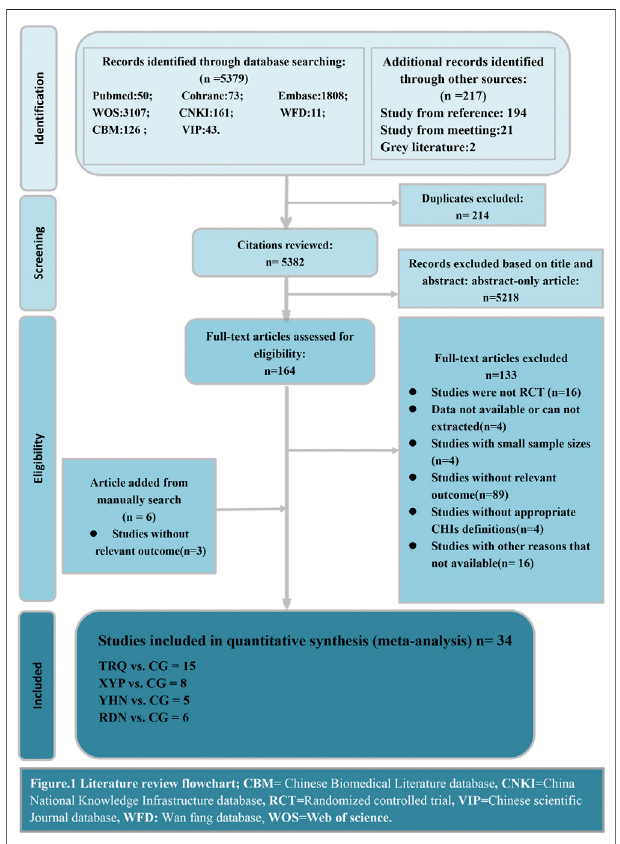
FIGURE 1 | Literature review fl owchart. CBM, Chinese Biomedical Literature database; CNKI, China National Knowledge Infrastructure database; RCT, Randomized controlled trial; VIP, Chinese scienti fi c Journal database; WFD, Wan fang database; WOS, Web of science.